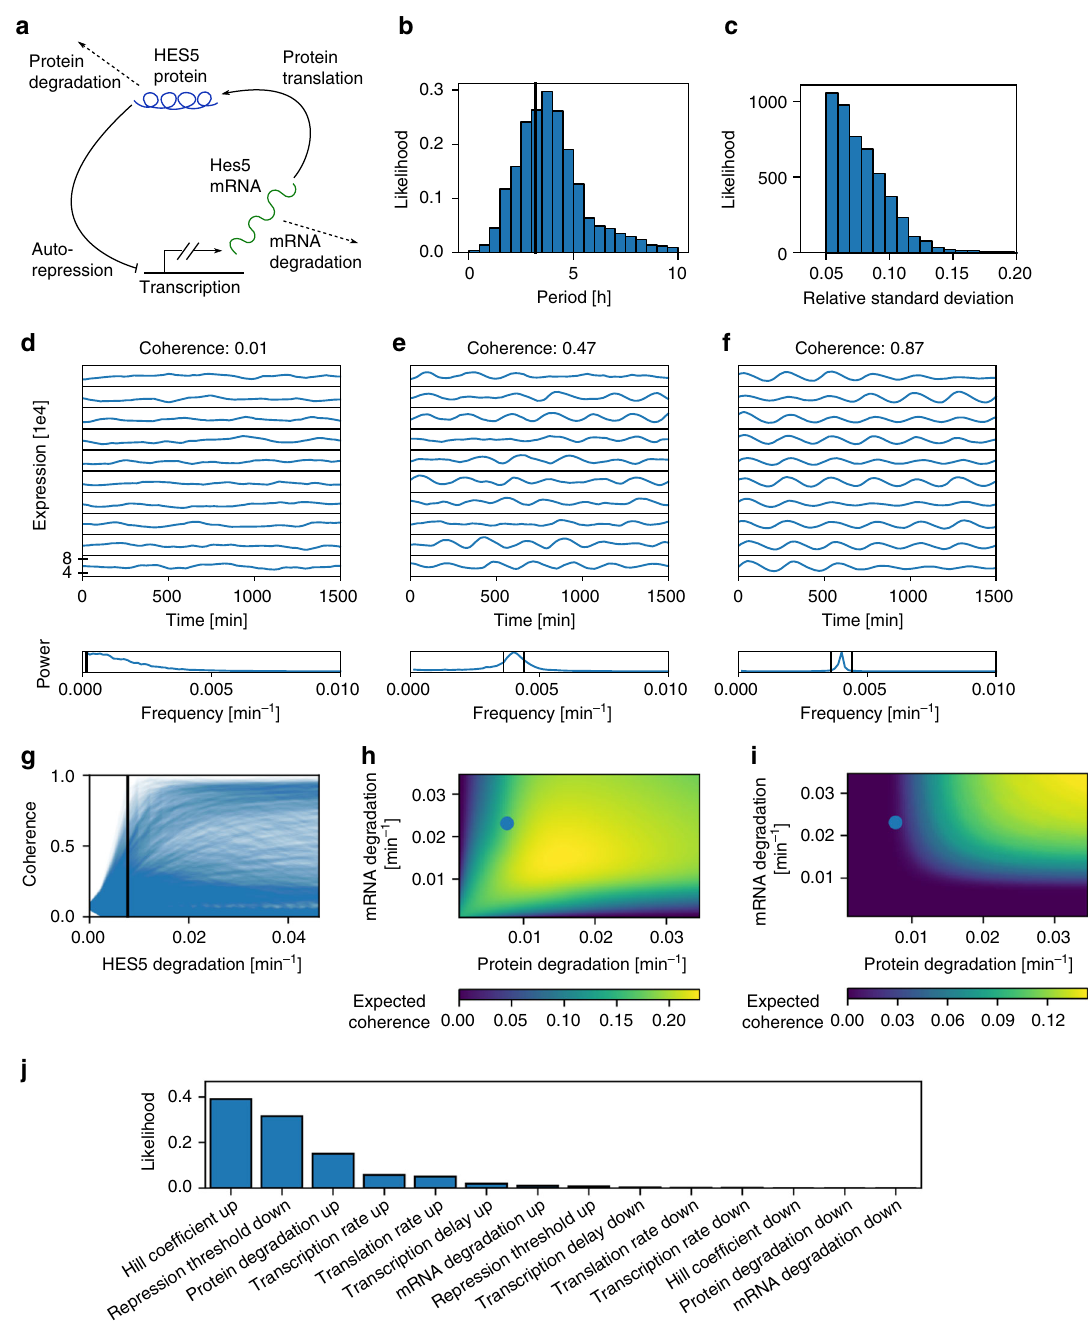
rise to different neuronal sub-types. Therefore, distance from the fl oorplate speci fi cally instructs neuronal sub-type with